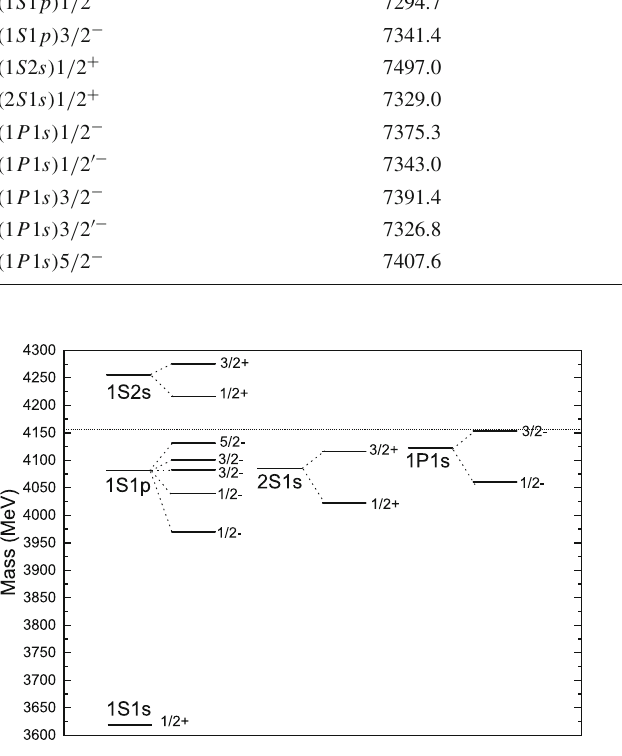
Fig. 2 Mass spectrum (in MeV) of the (cid:2) bb baryons, corresponding to the Table 11